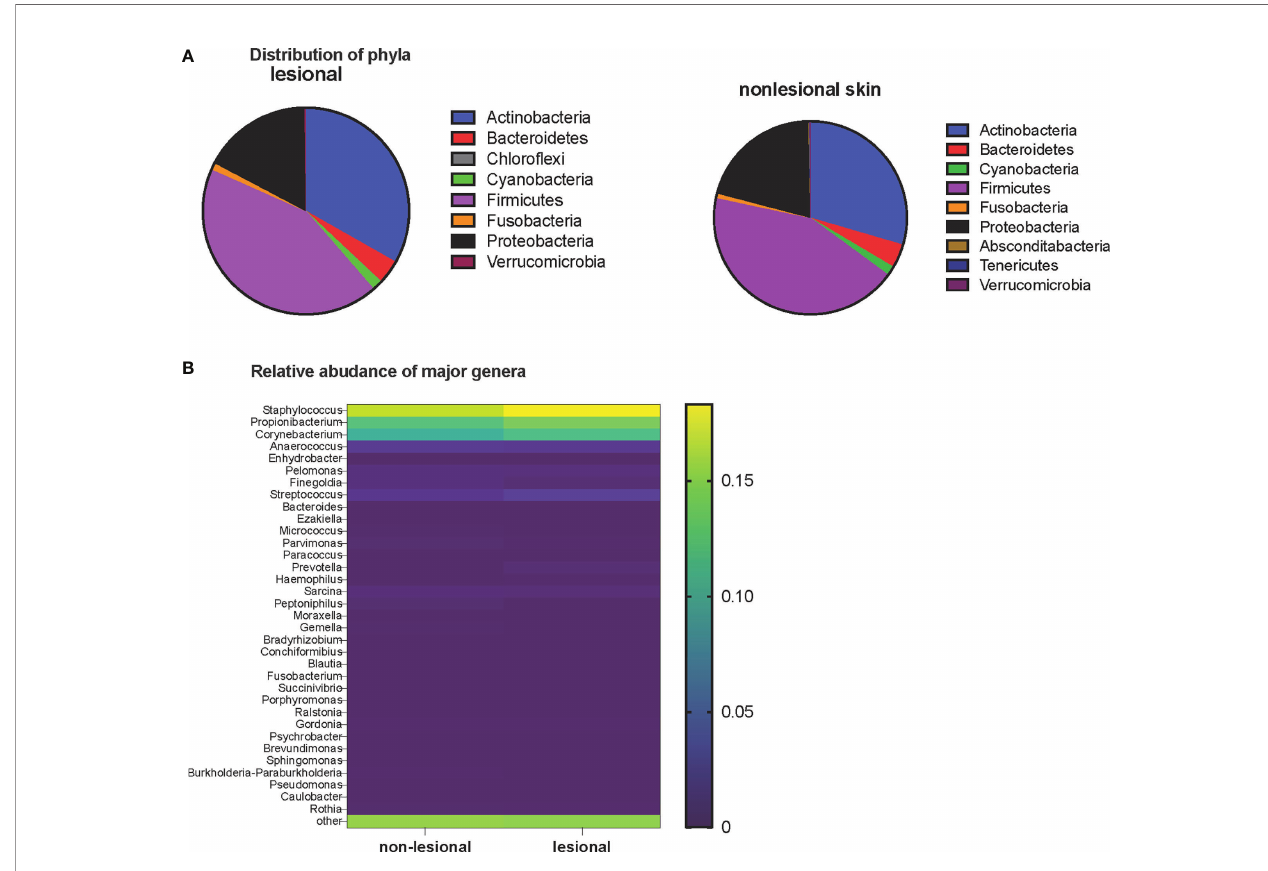
FIGURE 1 | (A) Distribution of phyla in the lesional (left pie chart) and non-lesional (right pie chart) skin of patients with MF. (B) Relative abundance of major genera in non-lesional and lesional skin. Heatmap is based on the logit-transformed median relative abundance. The top of the yellow color gradient bar corresponds to a median relative abundance of 20%, and the bottom of the purple gradient bar corresponds to a median relative abundance of